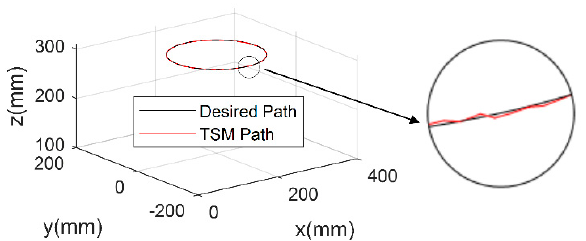
Figure 8. TSM-based trajectory tracking controller experimental result.